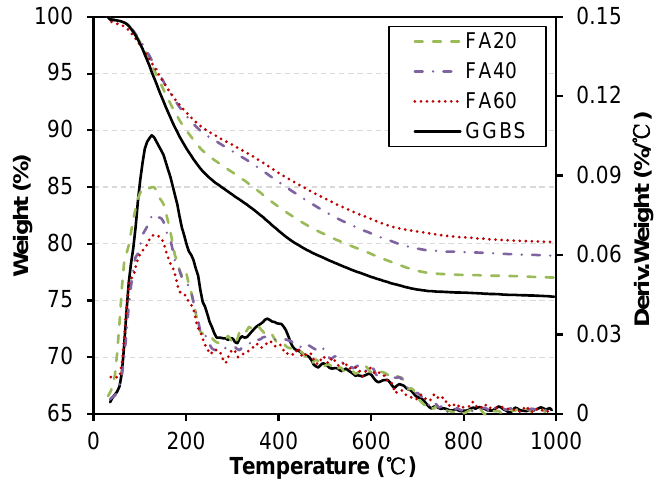
Figure 9. TG/DTG of GGBS, FA20, FA40, and FA60 pastes at 28 d.